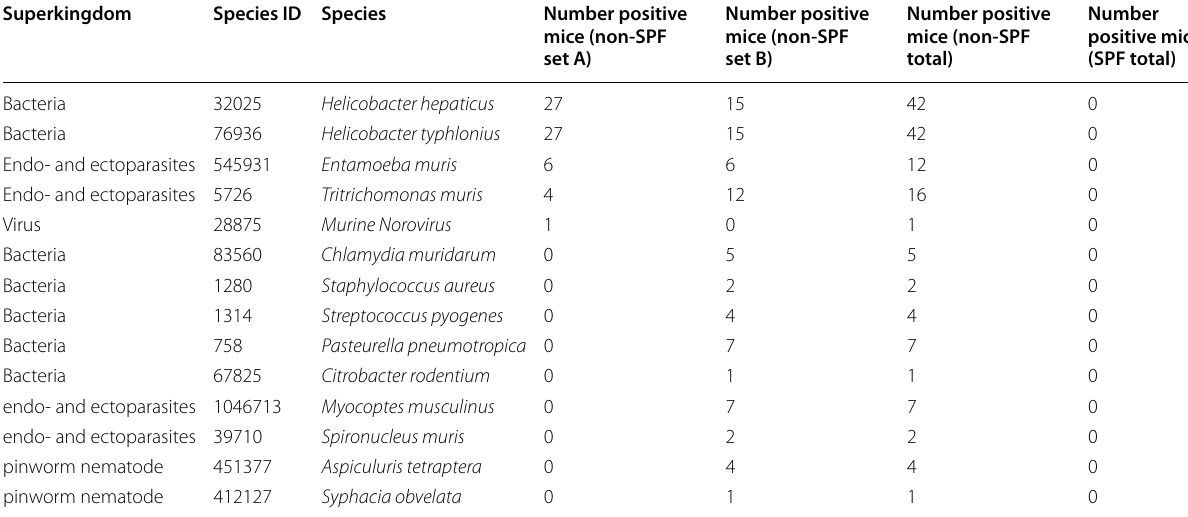
List of the pathogenic species identified by mNGS and number of positive mice for each species. Each different line represents one pathogen species identified in the course of the study. For each species there are columns that describe a short taxonomy (superkingdom, species ID, species); the last four columns indicate the number of non-SPF mice of set A (non-SPF set A), non SPF-mice of set B (non-SPF set B) non-SPF mice all sets (non-SPF total), which were found positive for at least one pathogen. No pathogens were detected in SPF mice (SPF total). All data were confirmed by PCR and sequencing